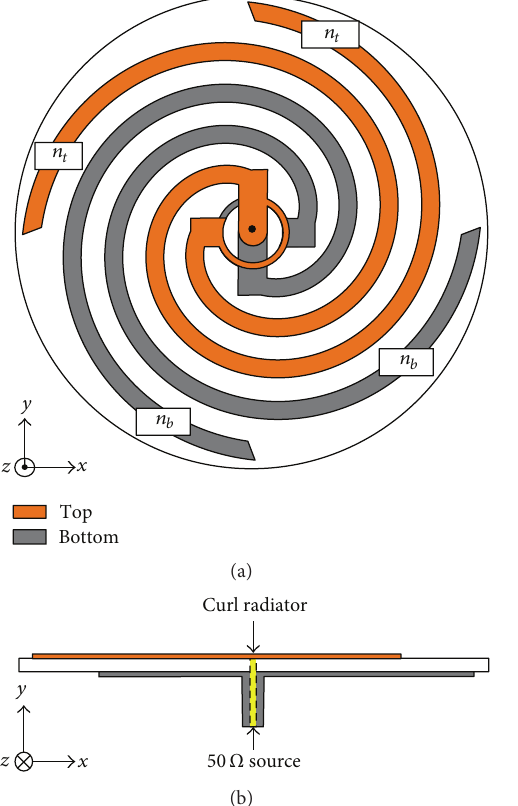
Figure 6: Four-arm curl antenna fed by double vacant-quarter printed rings [8]: (a) top view and (b) side view.